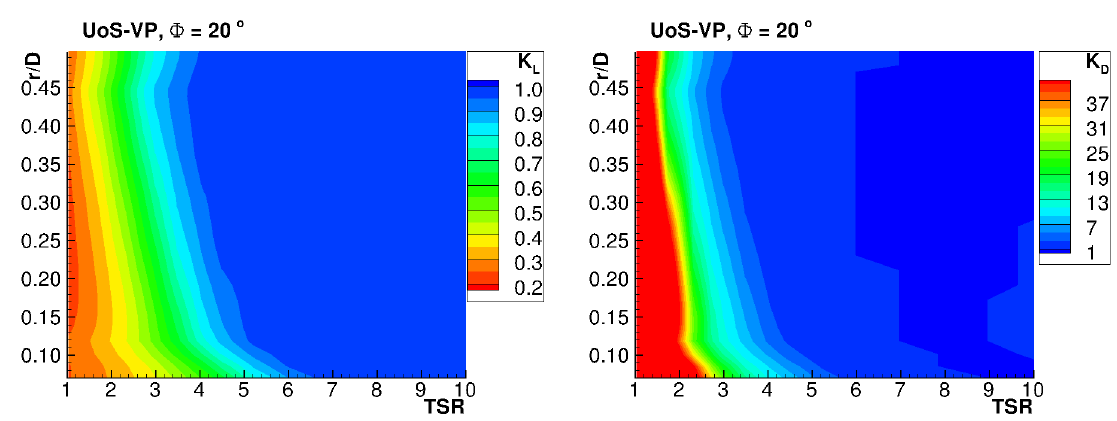
Figure 23. UoS-VP turbine. Correction factors for radial contributions to lift ( left ) and drag ( right ) as a function of radius r and of operating condition ( TSR ). Pitch setting Φ = 20 ◦ .